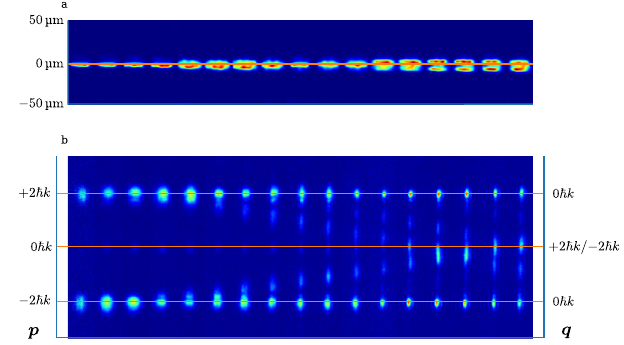
Fig. 5 | Examples of obtained image data. a Series of real space images for the system initially prepared in the qubit excited state of the quantum Rabi Hamilto- =2380 40 ð Þ Hz and g ω =6 : 5 ð 5 Þ , after deconvolution of the obtained raw nian, with ω q 2 π absorption imaging data of the atomic ensemble accounting for the point spread functionoftheusedoptics.Fromlefttorighttheinteractiontimeincreasesinsteps of 50 μ s. Despite the limited instrumental optical resolution, a splitting up of the atomic cloud isobserved. b Series of time-of- fl ight images ofthe atomiccloud,for the same system state as in a . The numbers on the left-hand side represent the measuredatomicmomentum p ,whiletheontheright-handsidethecorresponding quasimomentum q is